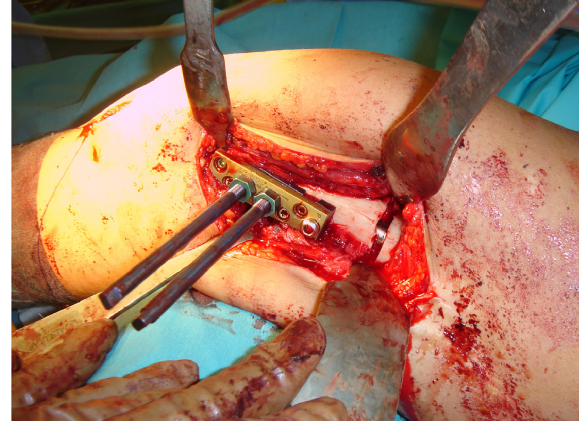
Figure 4. Intraoperative view of ONAS-DPS implantation in a 28-year-old female patient with congenital femoral shortening and deformity (osteotomy, intramedullary nail, plate with two Schanz screws). Note that there is no direct contact between Schanz screws and the bone or the IM nail.